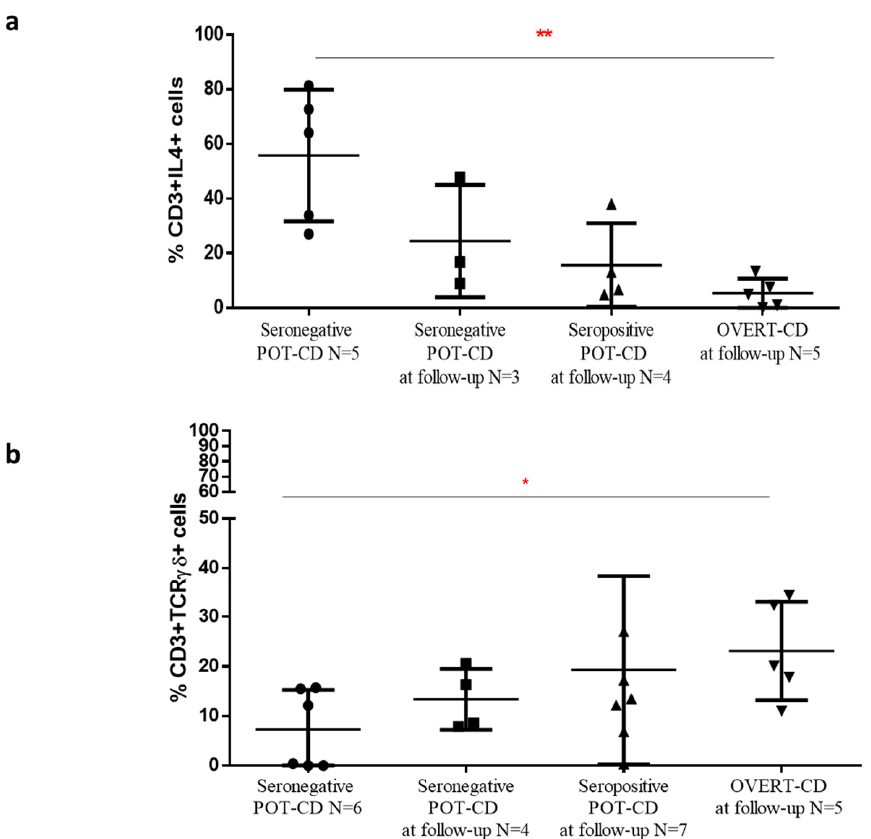
Figure 4. Densities of IL4+ T cells and TCR γδ + T cells in potential-CD patients stratified on the base of the outcomes at clinical follow-up. The percentages of intestinal ( a ) IL4+ T cells and ( b ) TCR γδ + T cells were calculated in duodenal samples of 22 children with potential-CD grouped on the basis of measurement of antibody titres and clinical evaluation done during the follow-ups, as follows: potential-CD with anti-tTG2 IgA levels below the cut-off at time of intestinal biopsy (Seronegative POT-CD); potential-CD with negative serology at follow-up (Seronegative POT-CD at follow-up); potential-CD with anti-tTG2 levels above the cut-off value at follow-up (Seropositive POT-CD at follow-up); potential-CD at time of flow cytometric analysis that developed villous atrophy over time, (OVERT-CD at follow-up). Data are shown as mean and standard deviation. Statistical analysis was performed using a Mann-Whitney test by GraphPad Prism Software, with a p ≤ 0.05 considered statistically significant and labelled with asterisk * p < 0.05, ** p < 0.01.